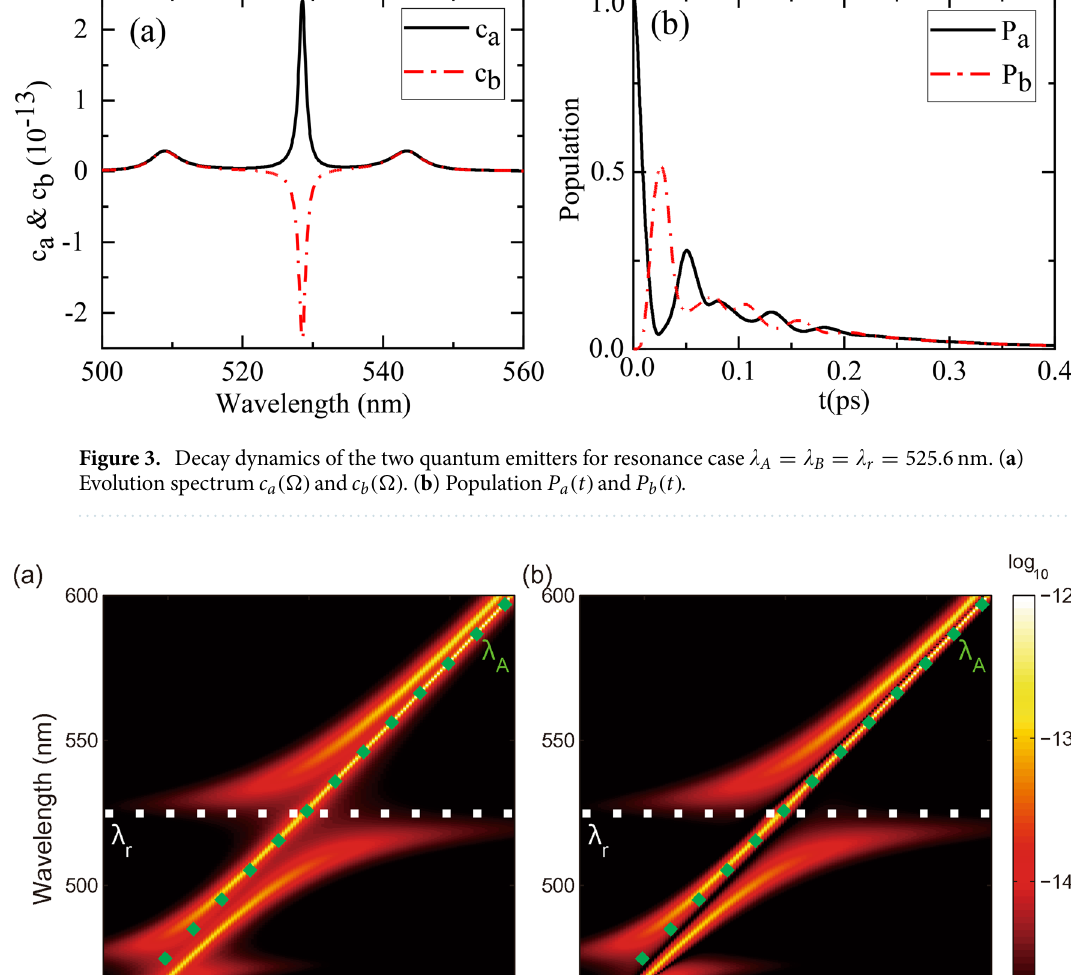
c b (�) for off-resonance case (cid:31) A | |